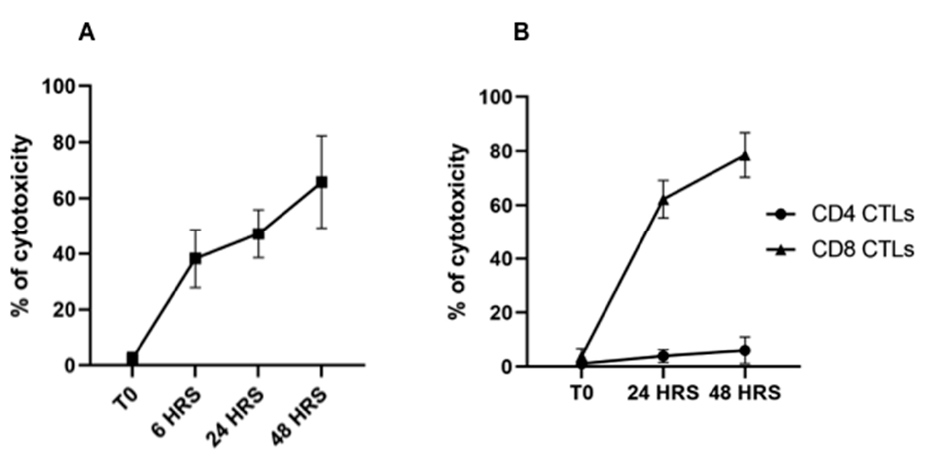
Figure 4. Comparison of the proportion of apoptotic and dead T. parva -infected target cells present in preparations incubated with T. parva -specific CD4 + and CD8 + T cells. ( A ) Display of dead and apoptotic infected target cells detected at 0, 6, 24, and 48 h incubation with CD4 + and CD8 + T cell parent cultures from T. parva -immunized steers stimulated ex vivo with autologous, irradiated, T. parva -infected cell lines. ( B ) Display of dead and apoptotic infected target cells detected at 0, 24, and 48 h incubation with CD4 + T cells (circles) or CD8 + T cells (triangles) previously stimulated ex vivo with irradiated, autologous T. parva -infected cell lines. Although most cytotoxic activity was mediated by CD8 + T cells, CD4 + T-cells also exhibited significant levels of infected target cell killing.